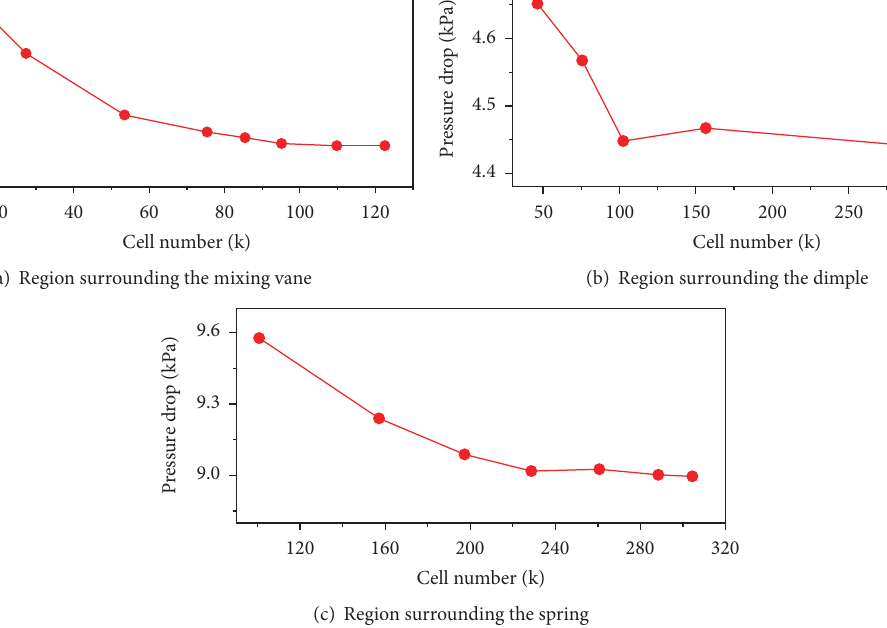
Figure 9: Mesh analysis for complex regions.